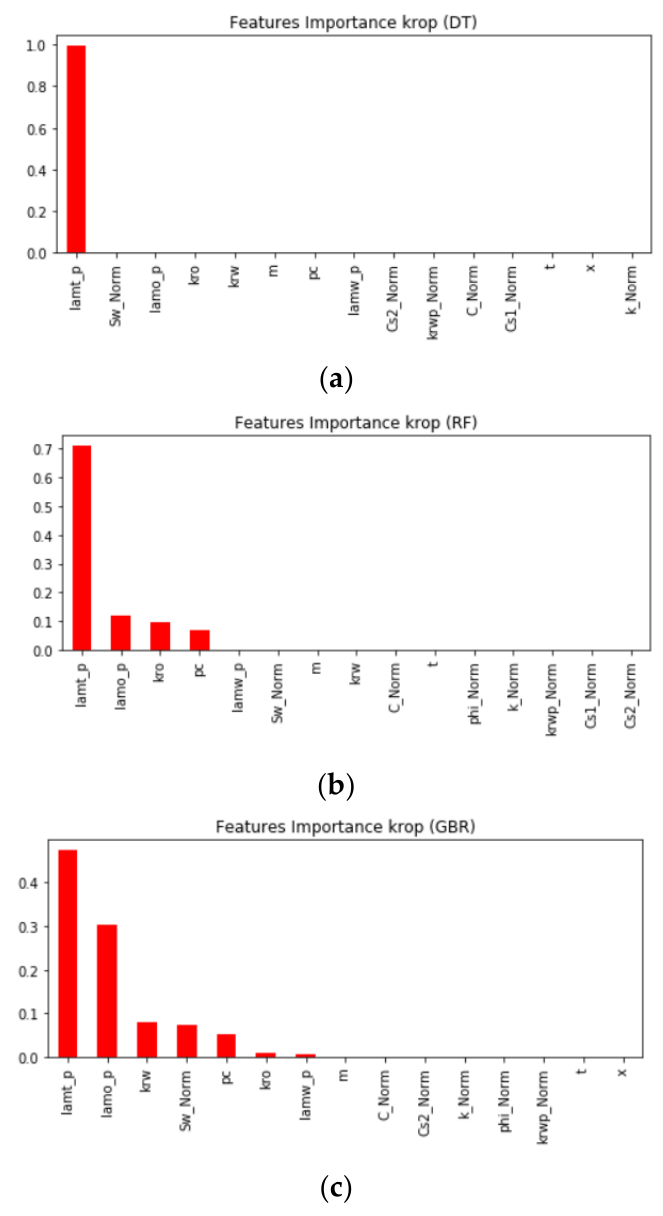
Figure 8. Features importance of ( a ) DT, ( b ) RF, and ( c ) GBR models for predicting k rop . Evaluating the models using different evaluation metrics, we found out that most of the models tested have high performance when the target variable is k rop , especially ANN models with standardized dataset and activation function of sigmoid that had RMSE value of 0.000145 and R 2 value of 1.000000. Figure 9 presents the scatterplot between the actual and the predicted k rop . Table 7 presents the metric evaluation results of all models. Figure 9 demonstrates the actual values and predicted values of k rop for all four models. It is